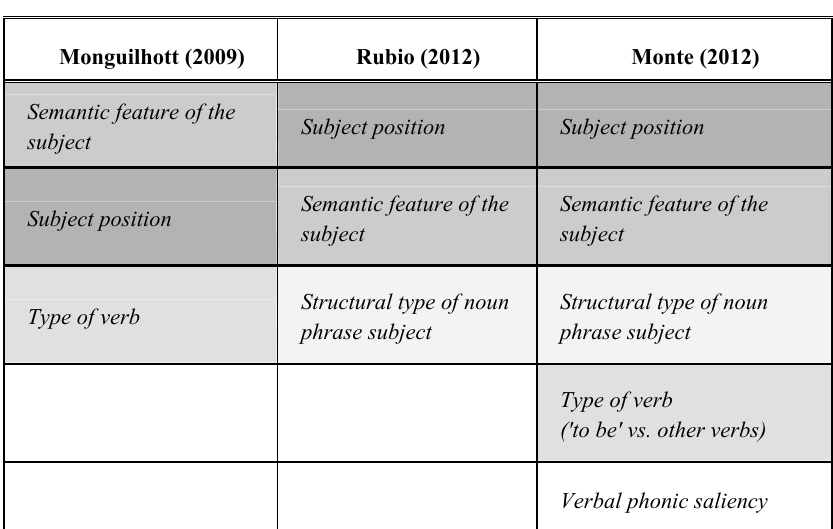
Table XXVI: Relevant variables in studies of third person plural verbal